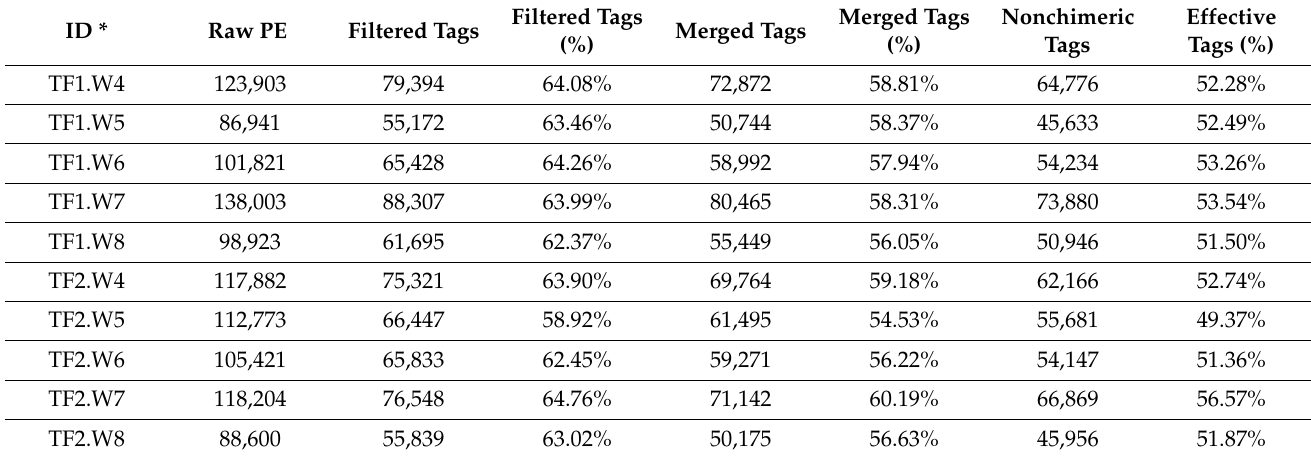
Table A1. Statistical summary of sequence